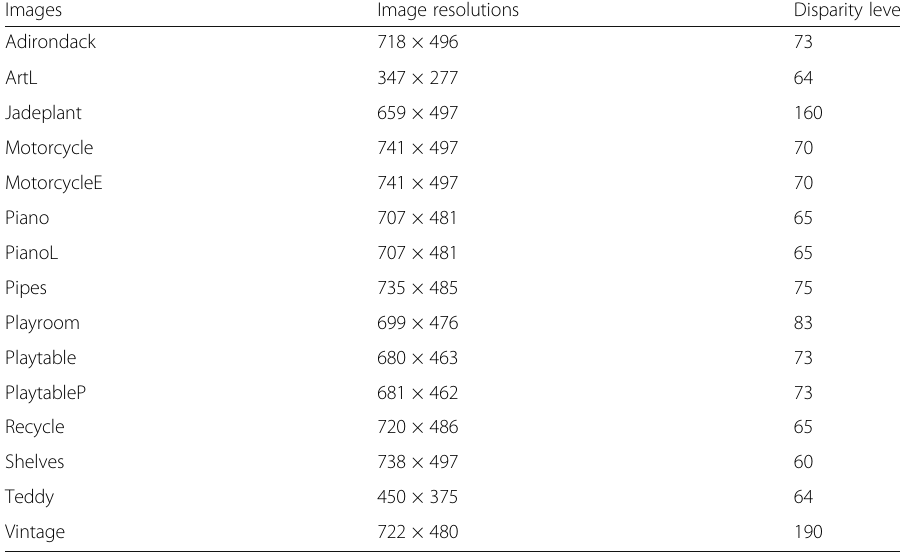
Table 2 Image information of Middlebury 2014